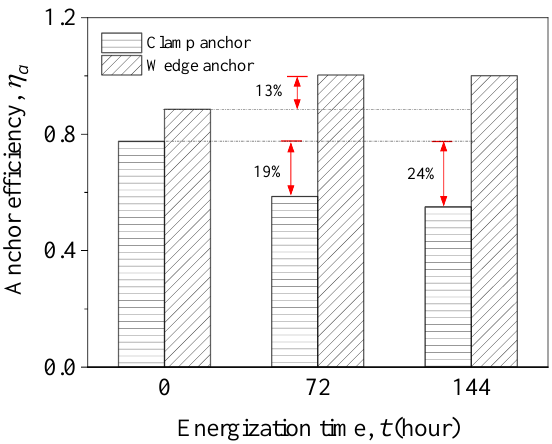
Figure 10. Changes in the anchor efficiency of anchors after accelerated corrosion.